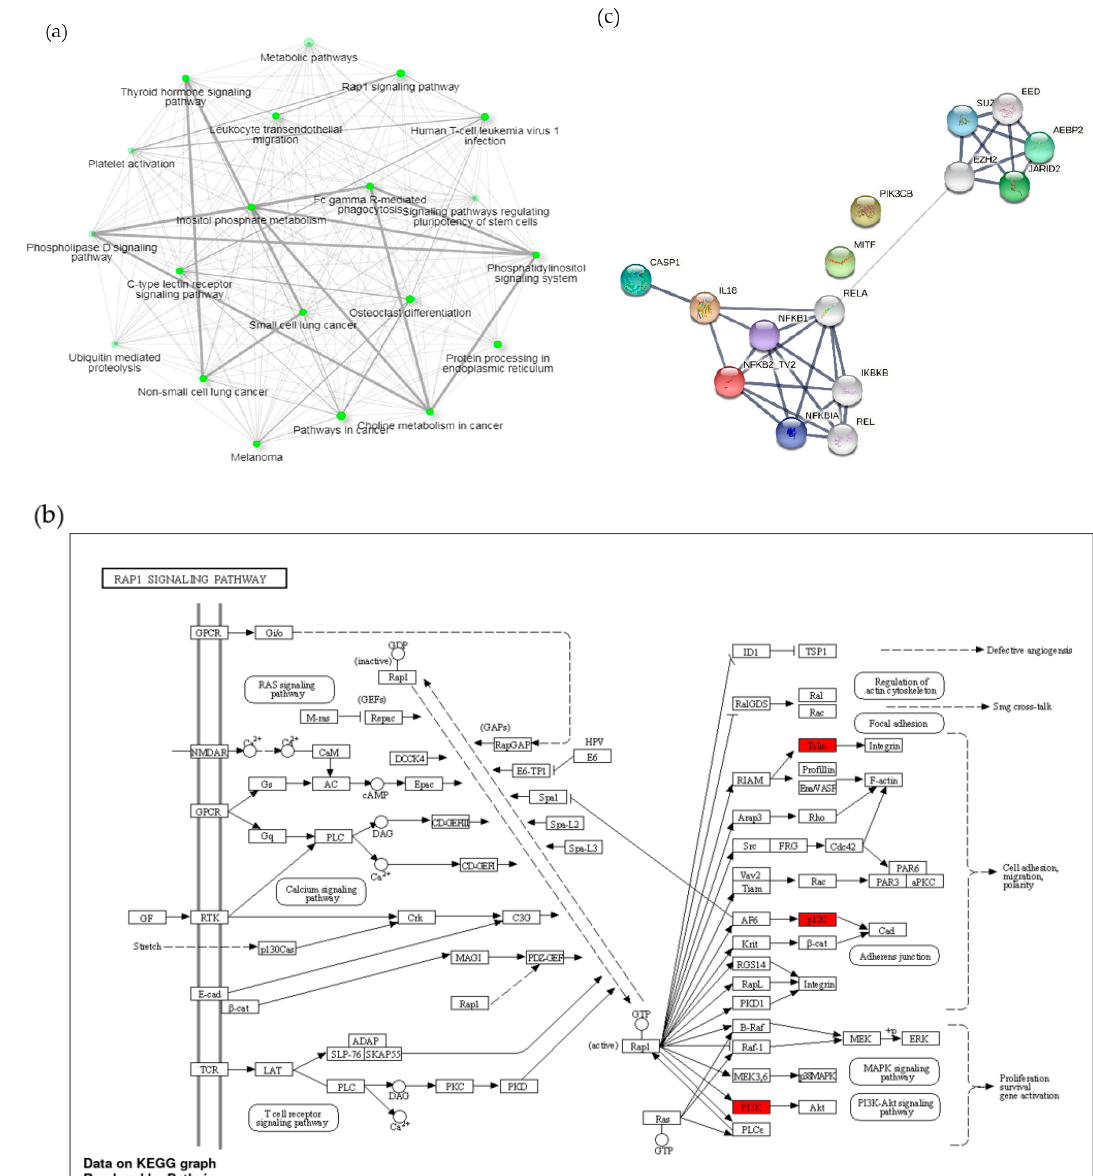
Figure 4. Network displaying the predicted interaction of signaling pathways and cytokine-related genes involved in immune response process. ( a ) Relationship between enriched pathways enhanced by up-regulated genes by A1 induction. Nodes represent each pathway; two nodes are connected if they share 20% or more genes. Darker nodes are more significantly enriched gene sets. Bigger nodes indicate larger gene sets. Thicker edges represent more overlapped genes. ( b ) Rap1 signaling pathways mediate TCR signaling pathway activation, thus promote proliferation, survival, and gene activation. Three out of 50 up-regulated genes are represented by the red box. ( c ) Protein-protein interactions involved in the activity of the immune response. Nodes with different colors represent different enriched